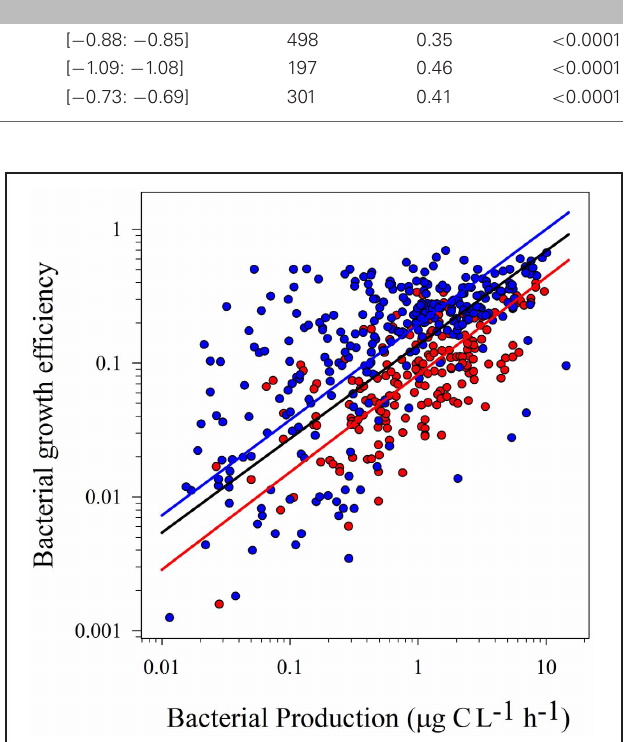
FIGURE 2 | Model II linear regressions between logBP and logBGE from temperate (blue dots and blue line; r 2 = 0 . 41; p < 0 . 0001) and tropical (red dots and red line; r 2 = 0 . 46; p < 0 . 0001) and the whole dataset (black line; r 2 = 0 . 35; p < 0 . 0001). See Table 2 for confidence